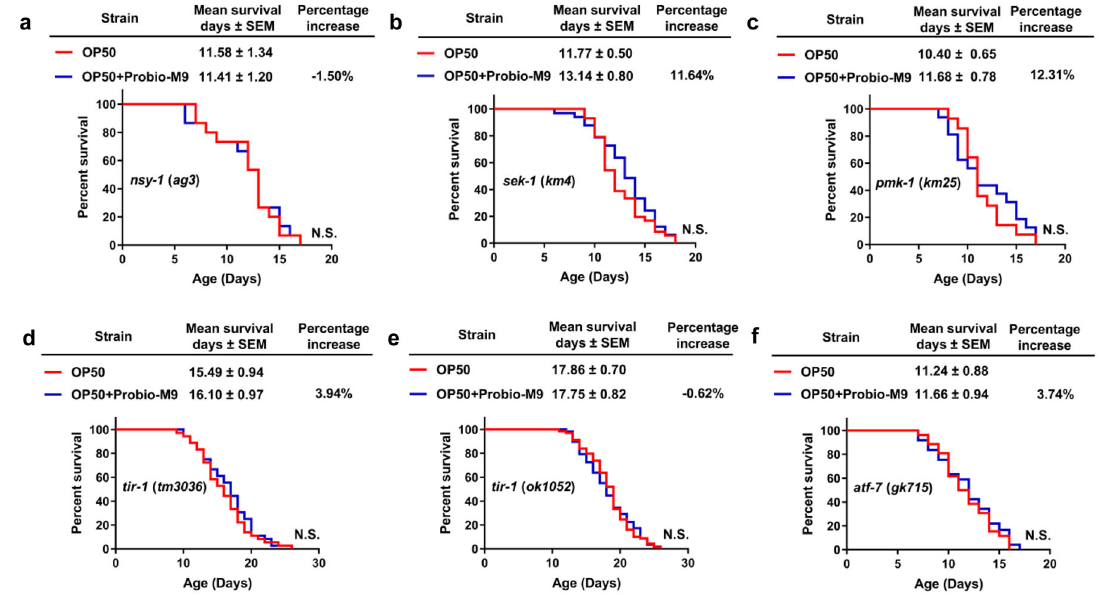
Fig. 4 Probio-M9 acts on p38 MAPK signaling pathway to delay aging. Survival curves of p38 MAPK signaling pathway mutants, nsy-1 ( ag3 ) ( a ), sek-1 ( km4 ) ( b ), pmk-1 ( km25 ) ( c ), tir-1 ( tm3036 ) ( d ), tir-1 ( ok1052 ) ( e ) and atf-7 ( gk715 ) ( f ) followed Probio-M9 feeding ( N = 90 worms, p > 0.05, Log rank